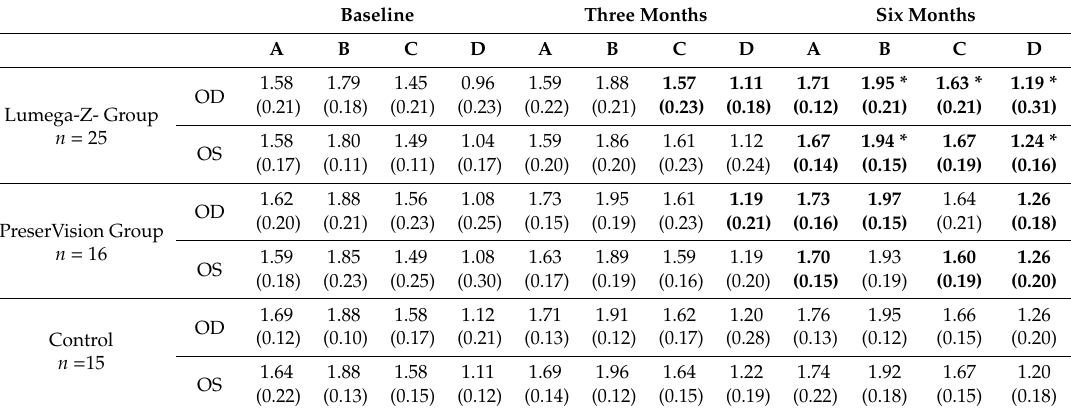
Table 2. Mean contrast sensitivity function measured by CSV-1000E in various